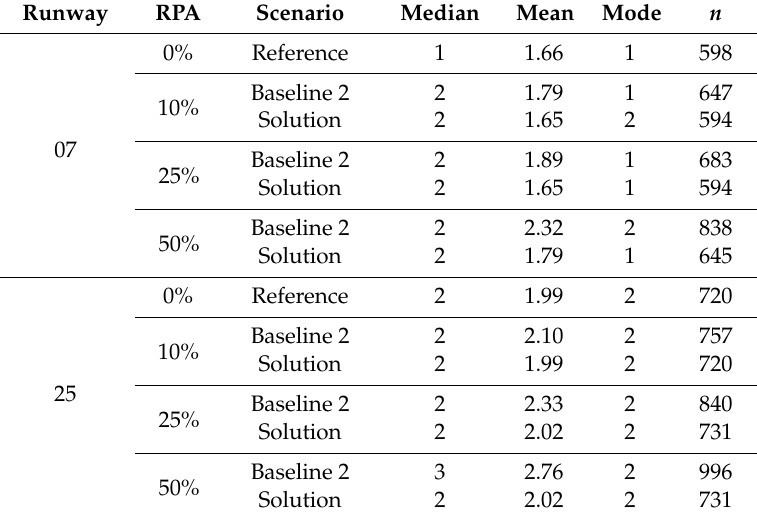
Table 7. Aircraft on ground statistics per simulation